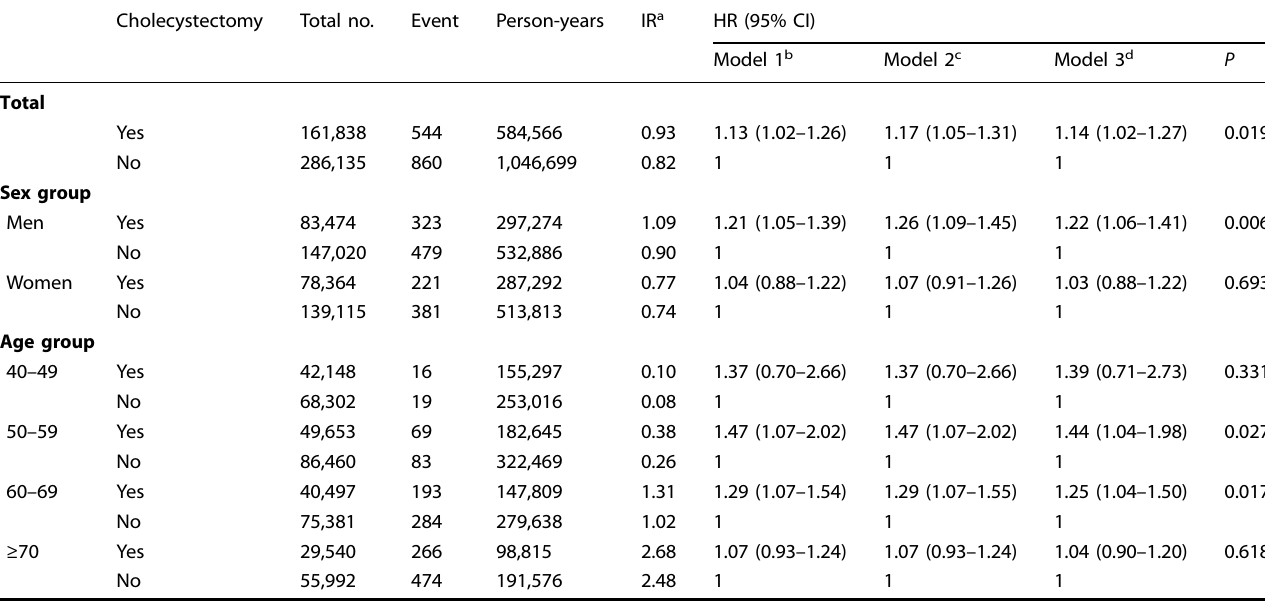
Table 2. IRs, HRs, and associated 95% CIs for Parkinson ’ s disease. Cholecystectomy Total